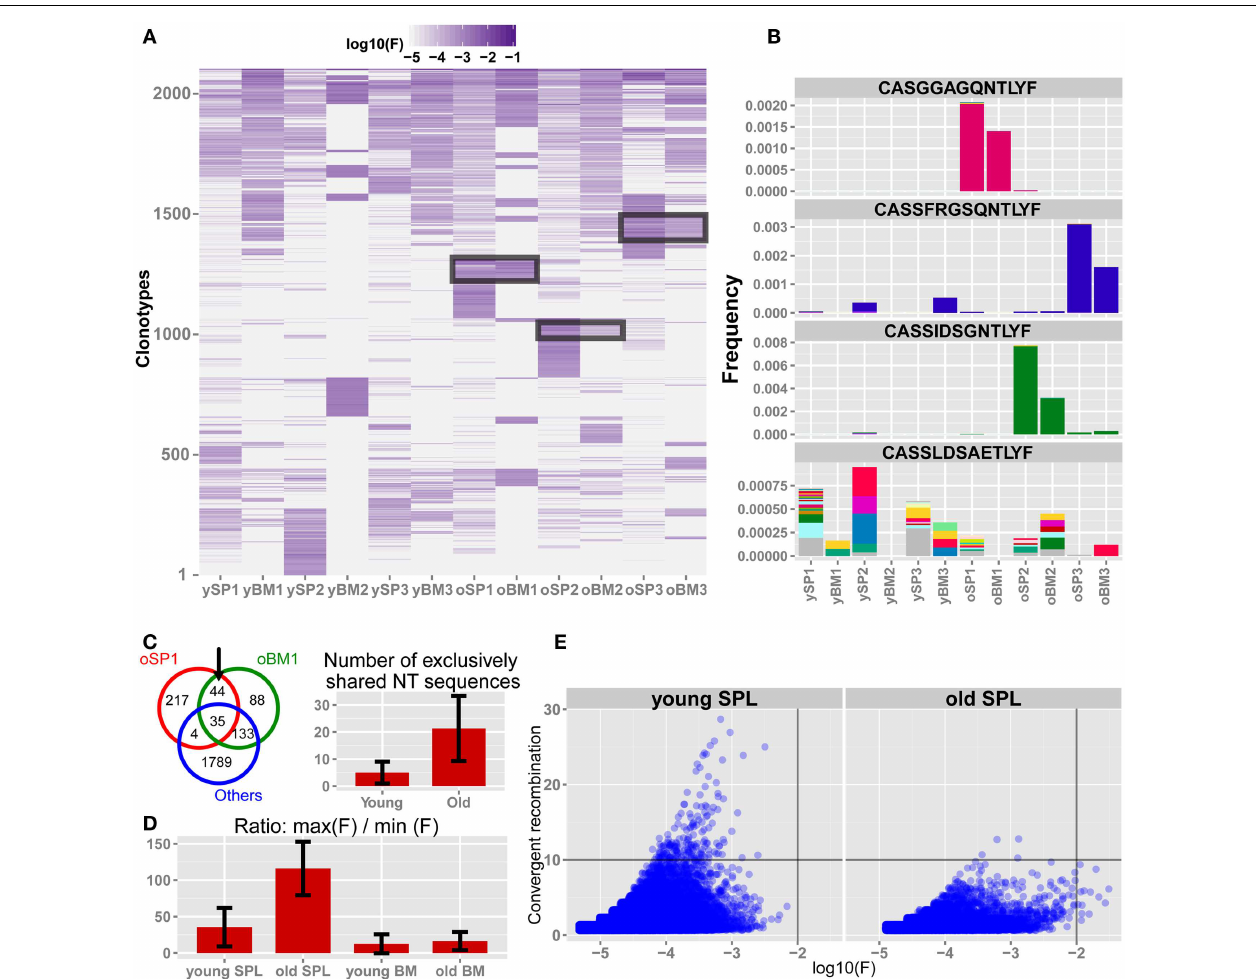
exclusively shared nt sequences.TheVenn diagram (left) shows an example in which 44 sequences are exclusively shared by BM and SPL of old mouse #1, and are not found in any other sample. Bar plot (right) shows that there are on average more exclusively shared nt sequences within SPL and BM of the same animal in old mice compared to young mice. Error bars indicate standard error. (D) Evaluation of clonal dominance. Bars show the average ratio between the frequency of the most frequent and the least frequent nt sequence encoding for the same AA sequence.Values were calculated for the top 300 AA clonotypes from each sample.The ratio is significantly higher in old SPL samples compared to young SPL ( p < 0.05, Student’s t test), suggesting clonal dominance. (E) Convergent recombination (# of nt sequences encoding each AA sequence) of AA clonotypes is plotted against their frequency. In old SPL the scatter shows a subset of high frequency clones that are encoded by less than 10 nt sequences (lower-right quadrant). In contrast, in young SPL many clonotypes show high convergent recombination (upper-left